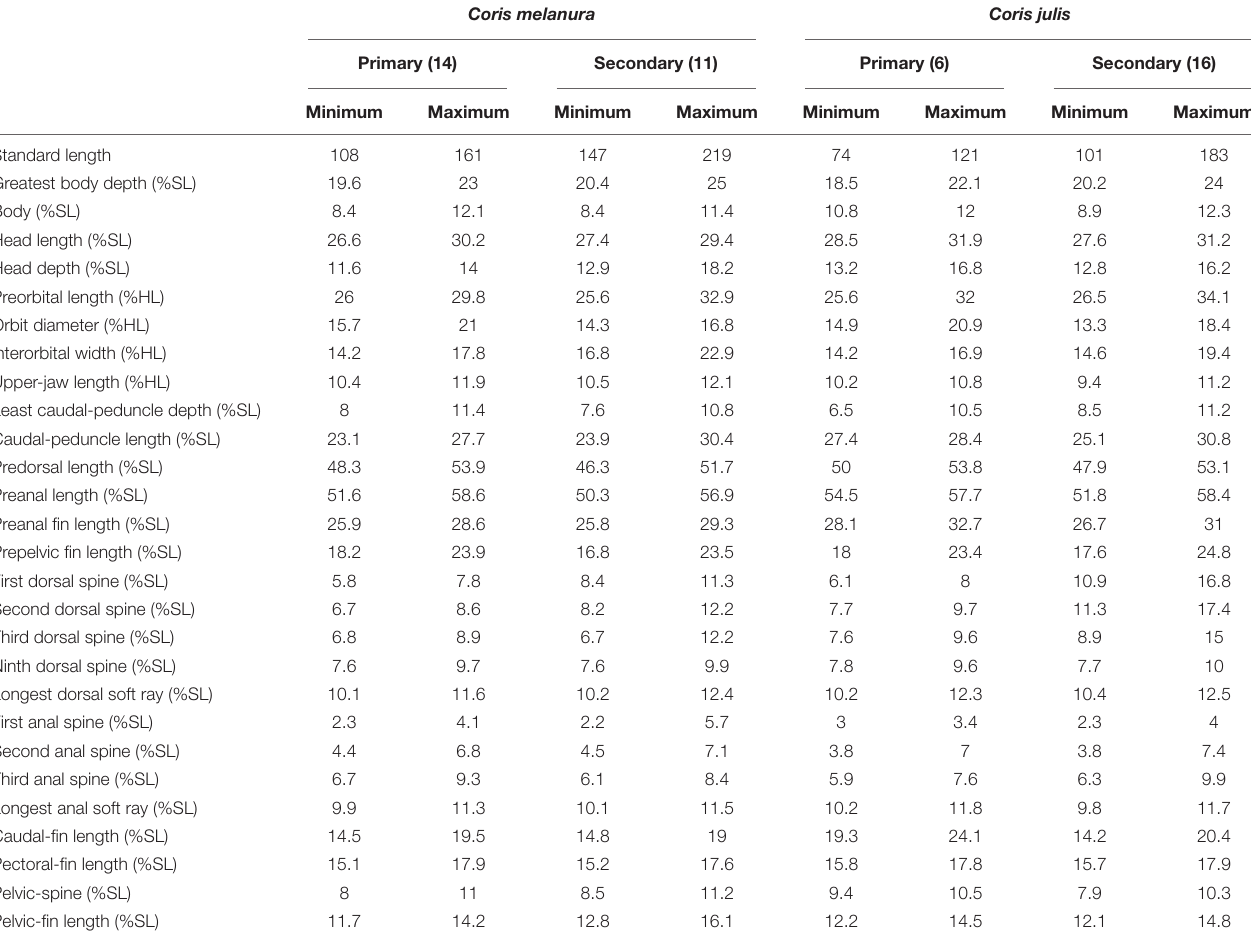
TABLE 2 | Range of measurements of Coris melanura and C. julis